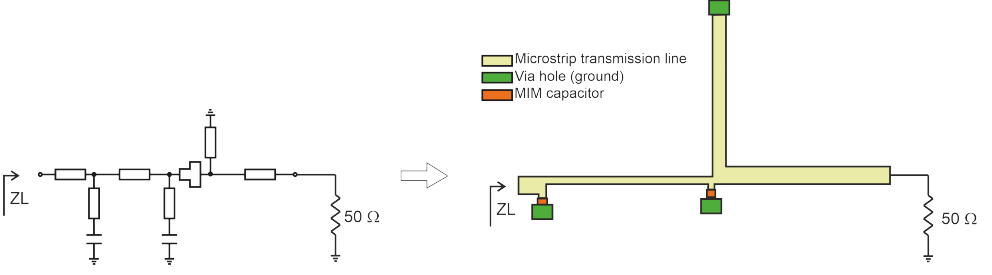
Figure 5. Circuit and layout of the matching network transforming Z L to 50 Ω